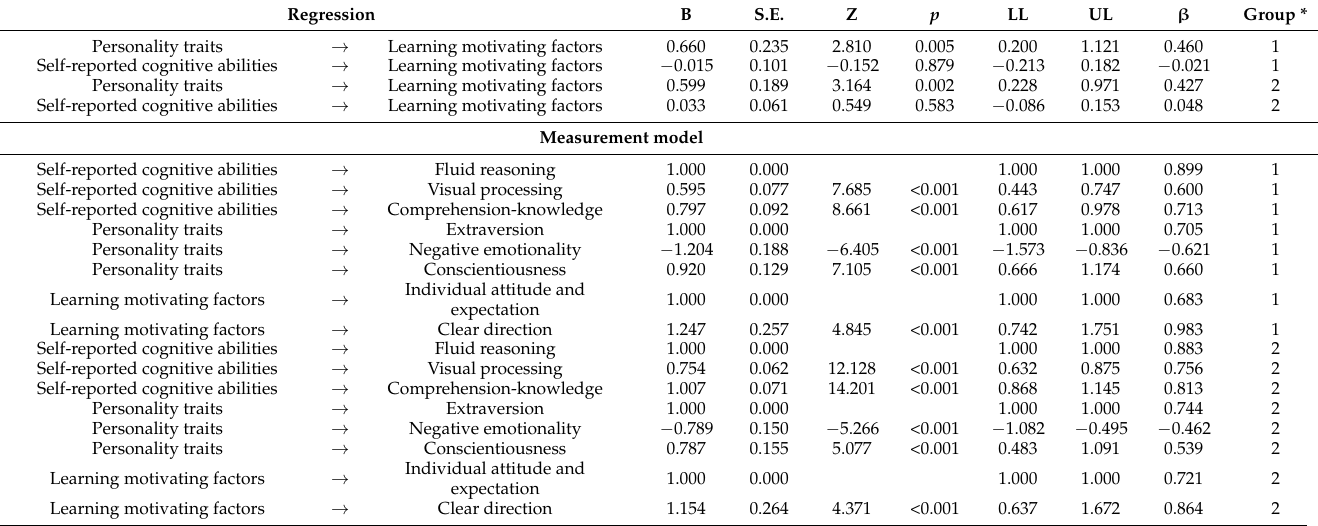
Table 11. Scalar estimates of the model on associations between learning motivating factors, self-reported cognitive abilities, and personality traits in both groups of participants and non-participants of computer programming e-learning based courses.